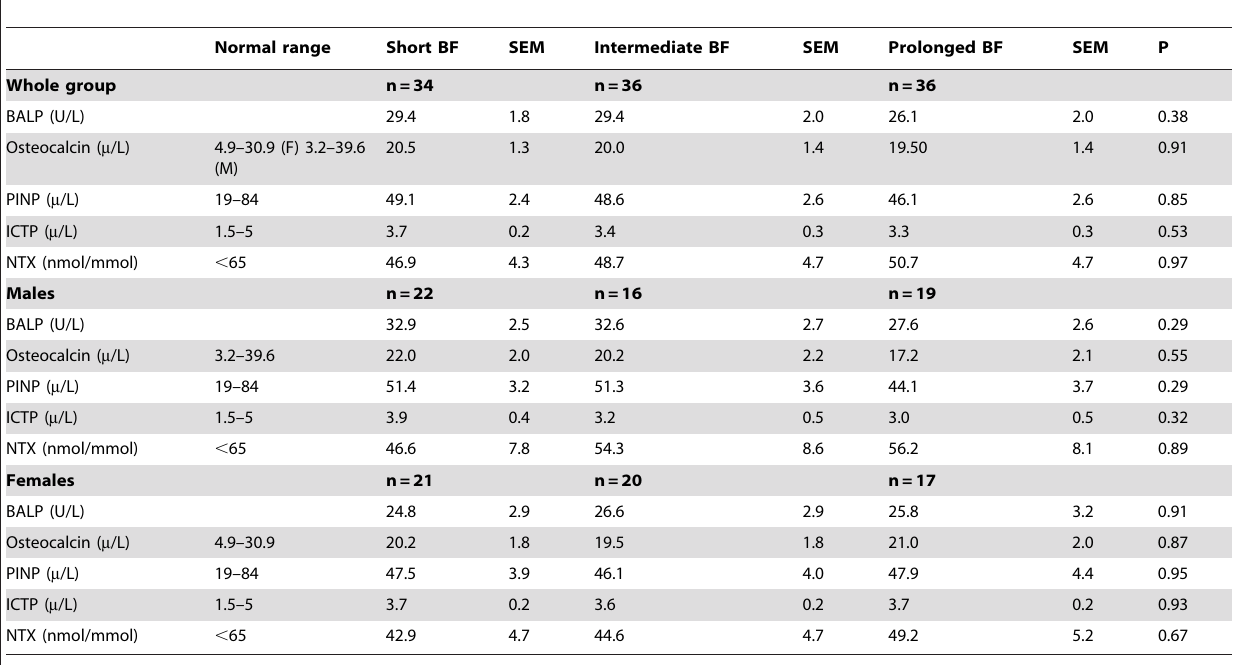
Table 3. Multivariate analysis of biochemical bone markers between the feeding groups.